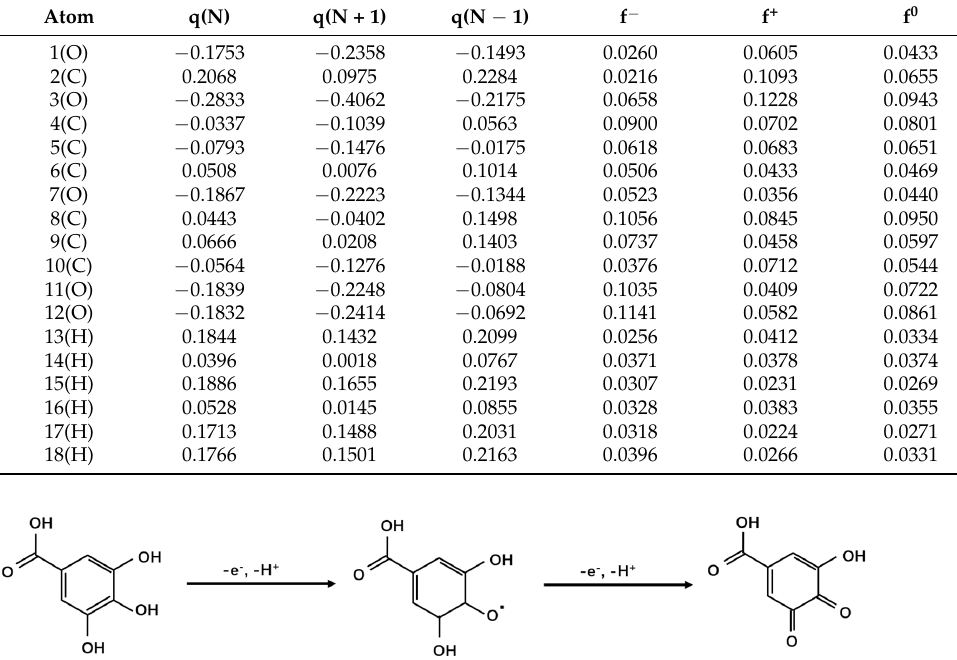
Table 2. Hirshfeld charges, condensed Fukui functions of each atom in GA.